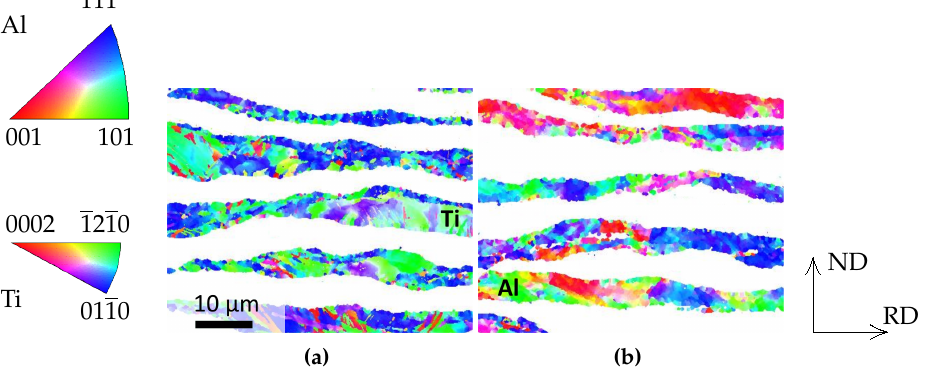
Figure 8. Electron backscatter diffraction (EBSD) maps of a five-layered composite sheet after eight ARB + IHT cycles. The maps are separated for Ti ( a ) and Al ( b ). The color code describes the crystal orientation in the rolling direction according to the inverse pole figure maps (shown leftmost for the cubic (Al, upper part) and hexagonal case (Ti, lower